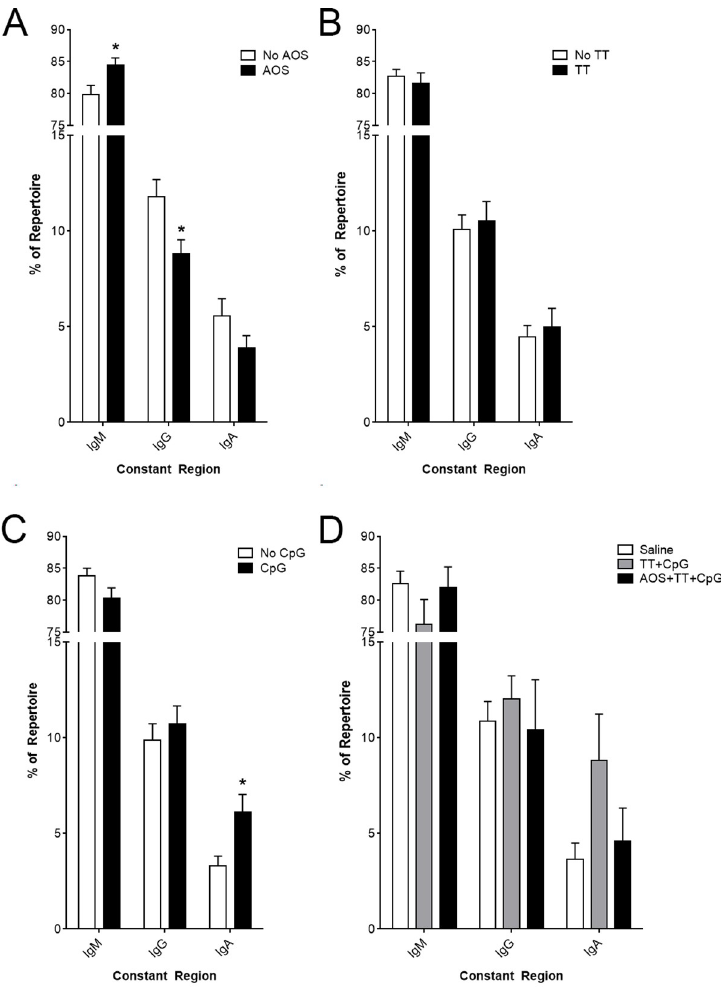
Fig 5. Impact of AOS, tetanus toxoid, and CpG on Splenic B cell constant region usage. Effects of (A) AOS, (B) TT, and (C) CpG on IgM, IgG, and IgA constant region. (D) Constant region usage in saline, TT+CpG, and AOS+TT +CpG. � = P < 0.05, �� = P < 0.01, ��� = P <